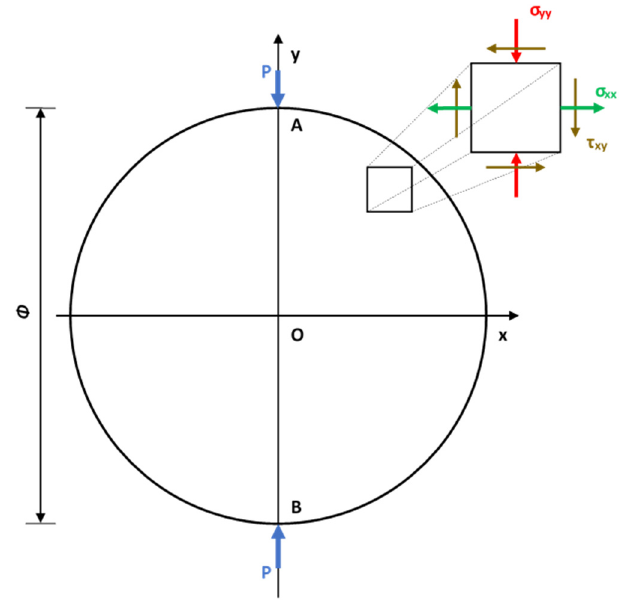
Figure 4. Elastic stress field developed in a flat ‐ faced tablet during diametrical compression.